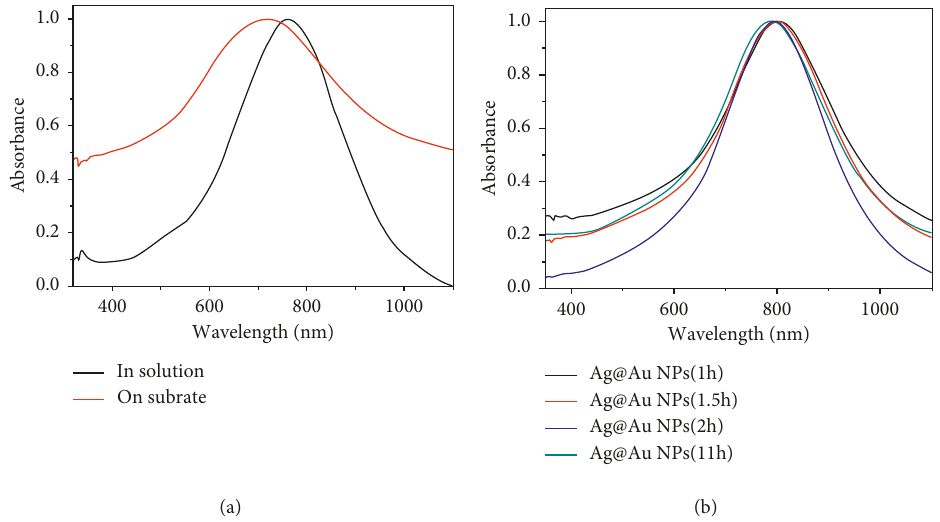
Figure 4: (a) UV-IR extinction spectra of Ag@Au core-shell NPs in aqueous solution and assembled on glass slides. (b) LSPR peaks, before and after normalization, of glass slides soaked in Ag@Au core-shell NP solution for different periods of time.